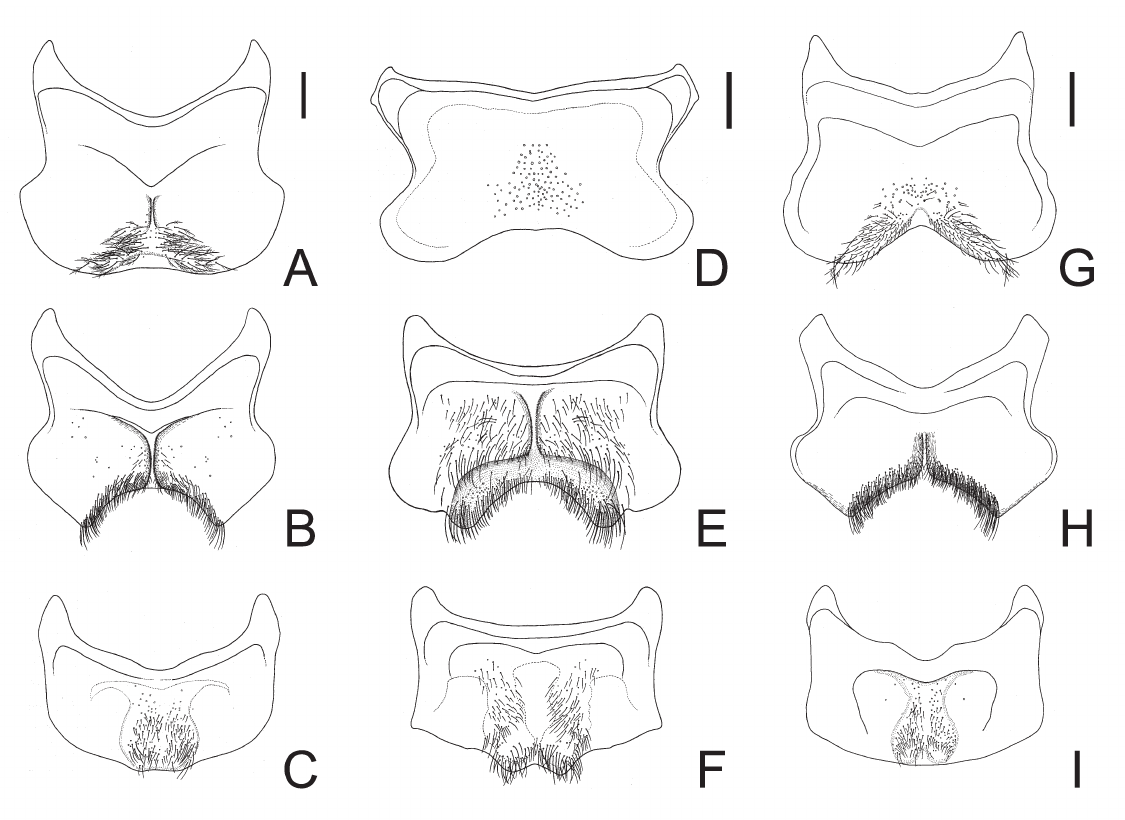
Fig. 14. S4–S6 in species of the problematicum subgroup, ♂. A–C . Lasioglossum ( Dialictus ) problematicum (Blüthgen, 1923). D–F . Lasioglossum ( Dialictus ) sanitarium (Blüthgen, 1926). G–I . Lasioglossum ( Dialictus ) alishanense Murao sp. nov., paratype. a, d, G: S4. B, e, h: S5. c, F, i. S6: dotted area on S5 shows the apical depression. Scale bars: